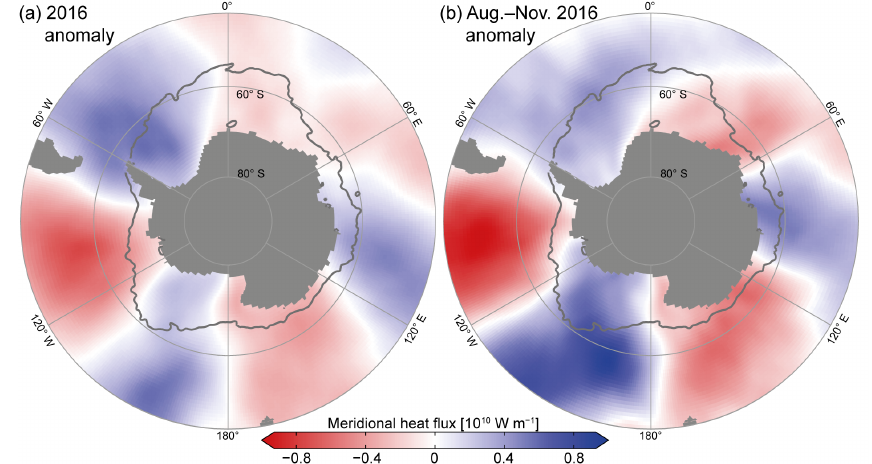
Figure 8. Averaged monthly anomalies of the vertically integrated meridional heat fluxes (positive northward) from ERA-Interim for the year 2016 (a) and the period August to November 2016 (b) with respect to the climatological monthly means of the period 1979 to 2015. The gray contour line denotes the November 2016 monthly mean sea ice edge (15%